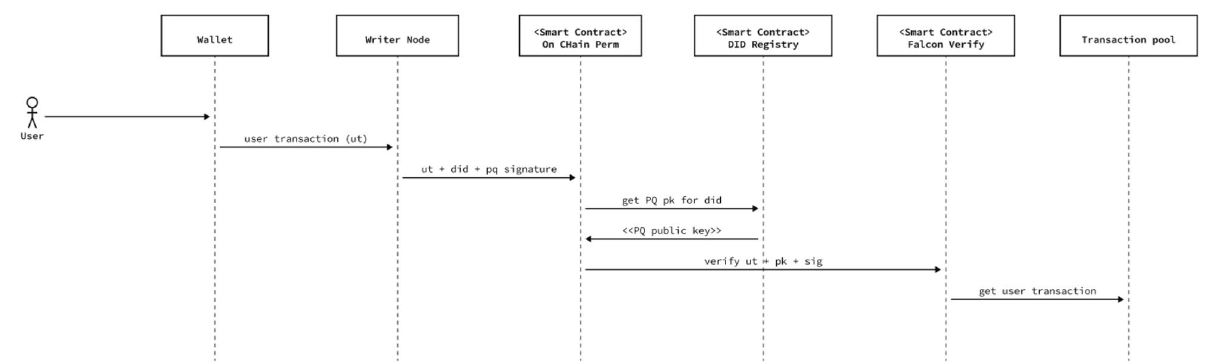
Figure 8. High level diagram illustrating the flows from the generation of a transaction to the incorporation of that transaction to the transaction pool of a node, after validating the post-quantum